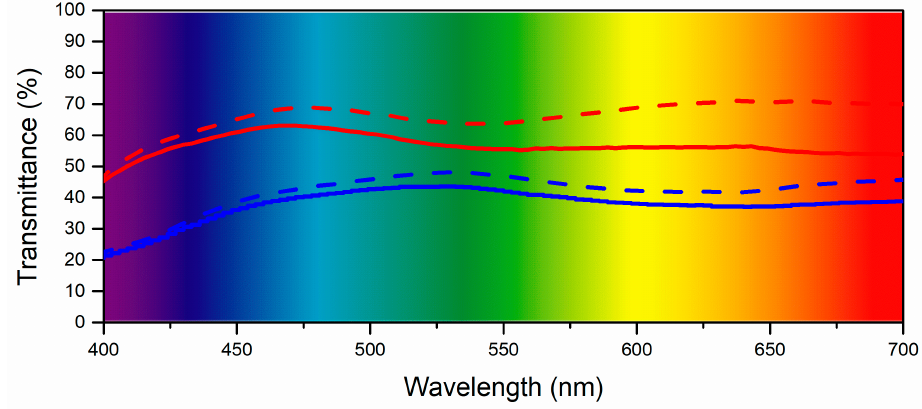
Figure 5. Transmission spectra of the ECD@LiTrif-ErTrif 3 (blue) and ECD@LiTrif-[Er(tta) 3 (H 2 O) 2 ] (red) devices in the colored (solid line) and bleached (dashed line) states (first coloring/bleaching cycle).